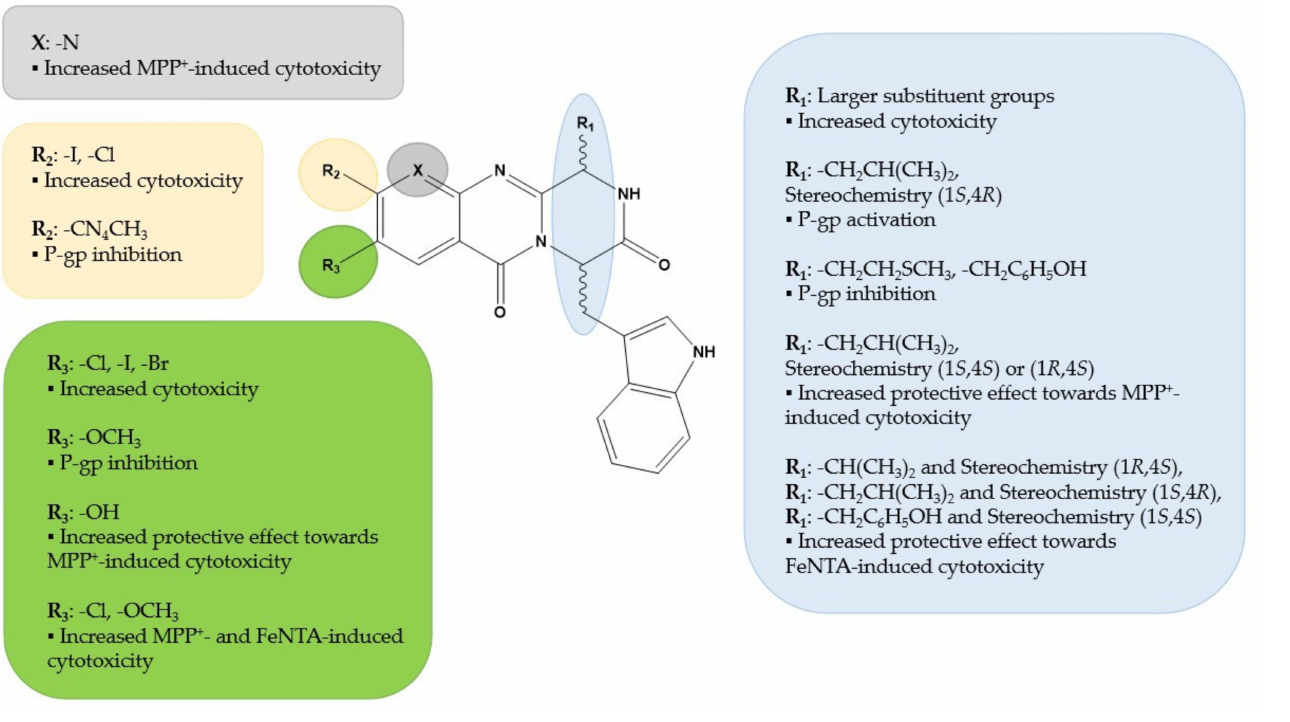
Figure 6. Structure–neuroprotective activity relationship for the fiscalin derivatives under investiga- tion in the present